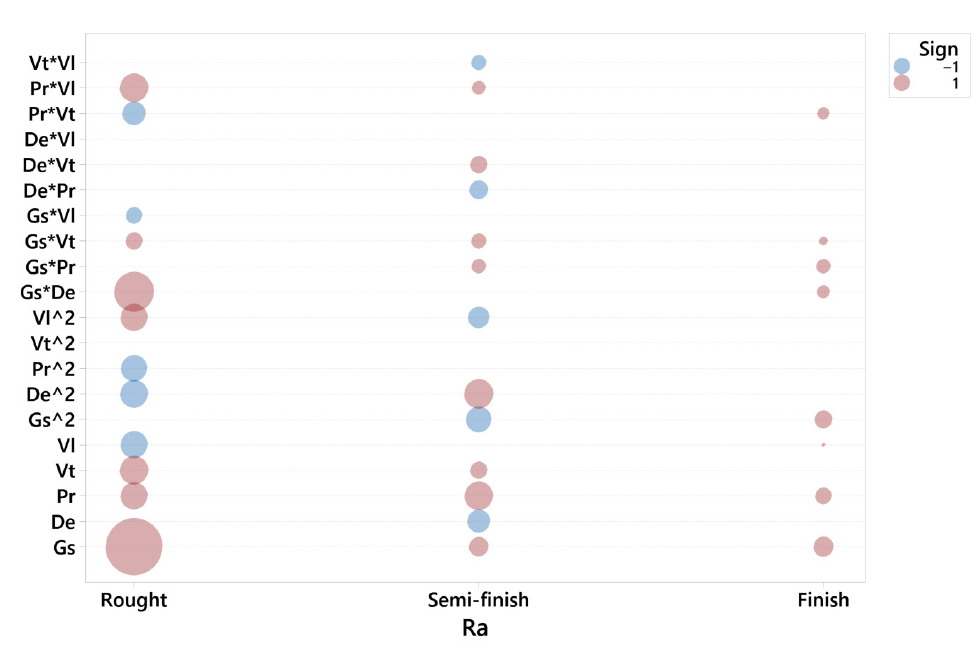
Figure 6. Significant terms for Ra in the rough, semi-finish and finish